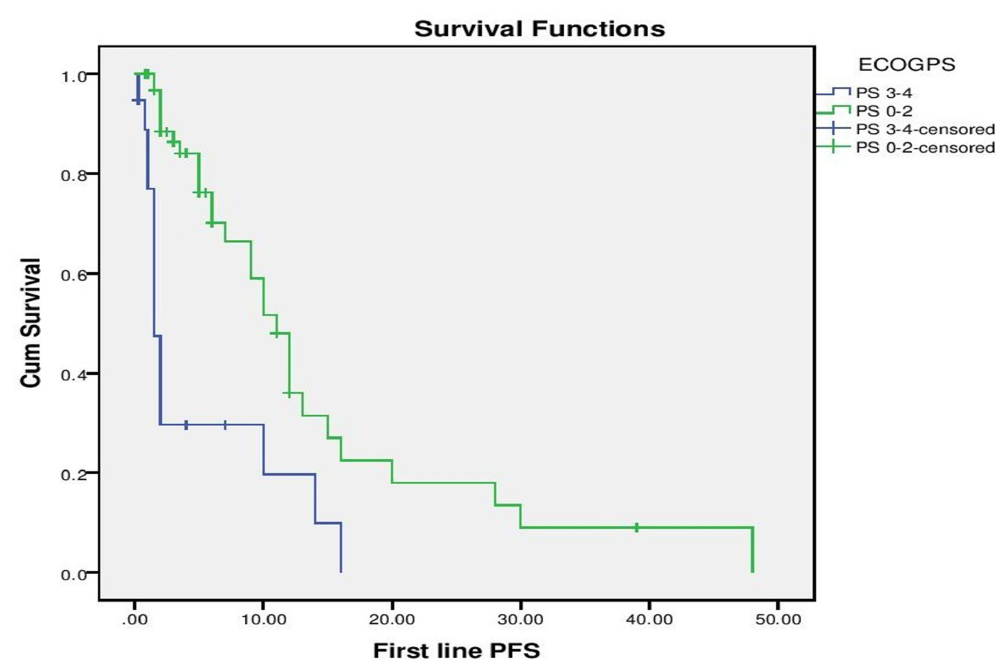
Fig 3. Progression Free Survival as per Performance